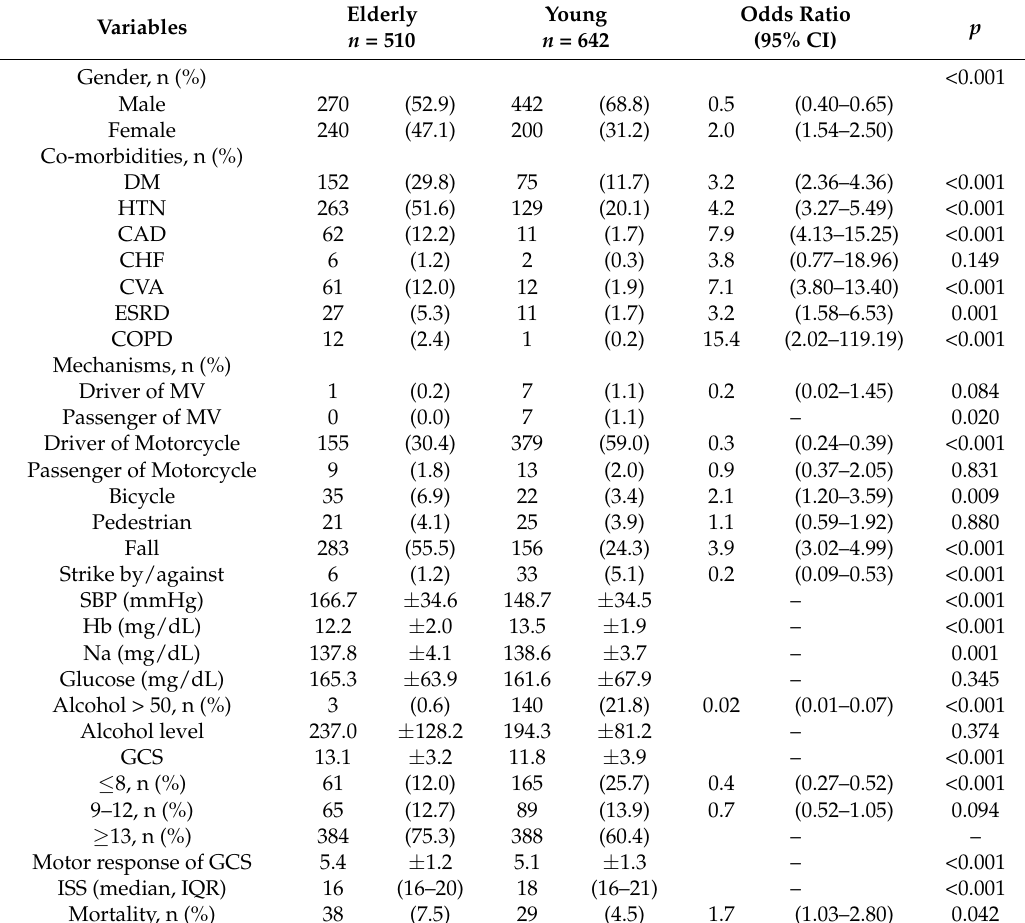
Table 2. Comparison of the characteristics and outcomes of the elderly and young adult patients with head AIS of